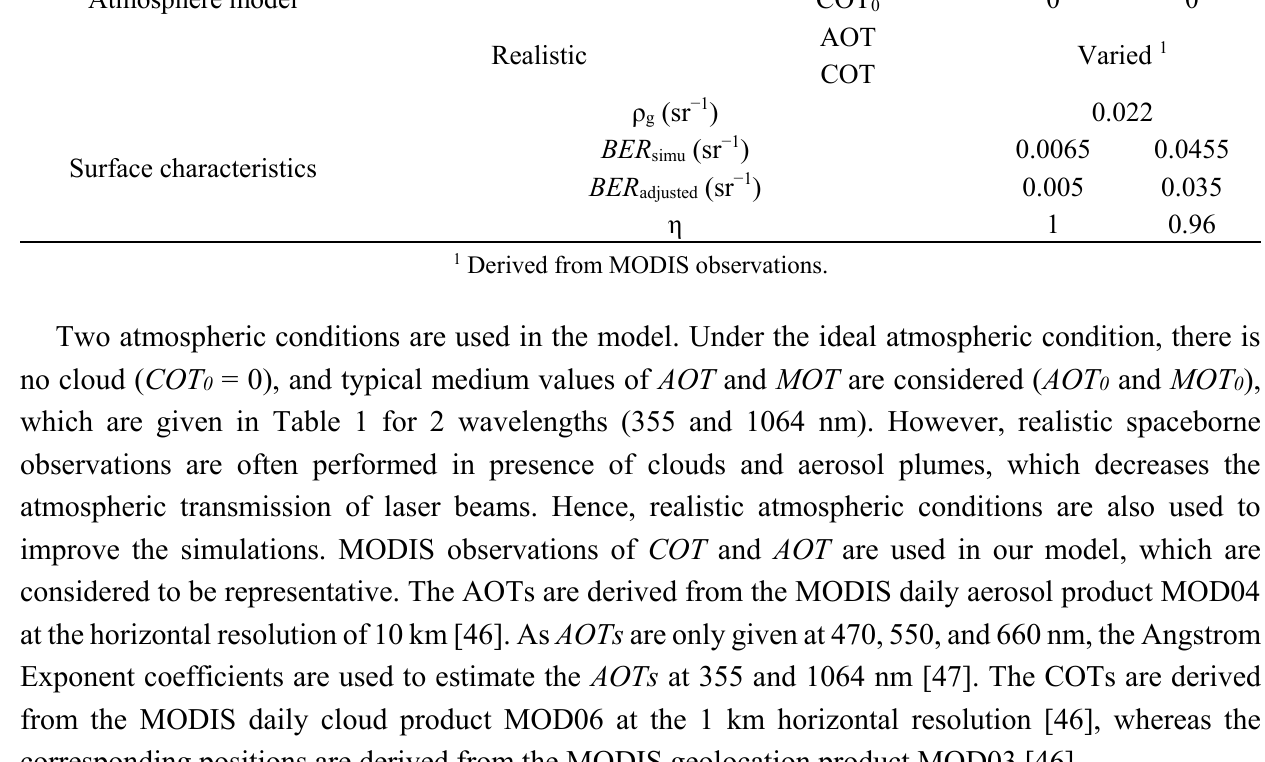
Instrument model